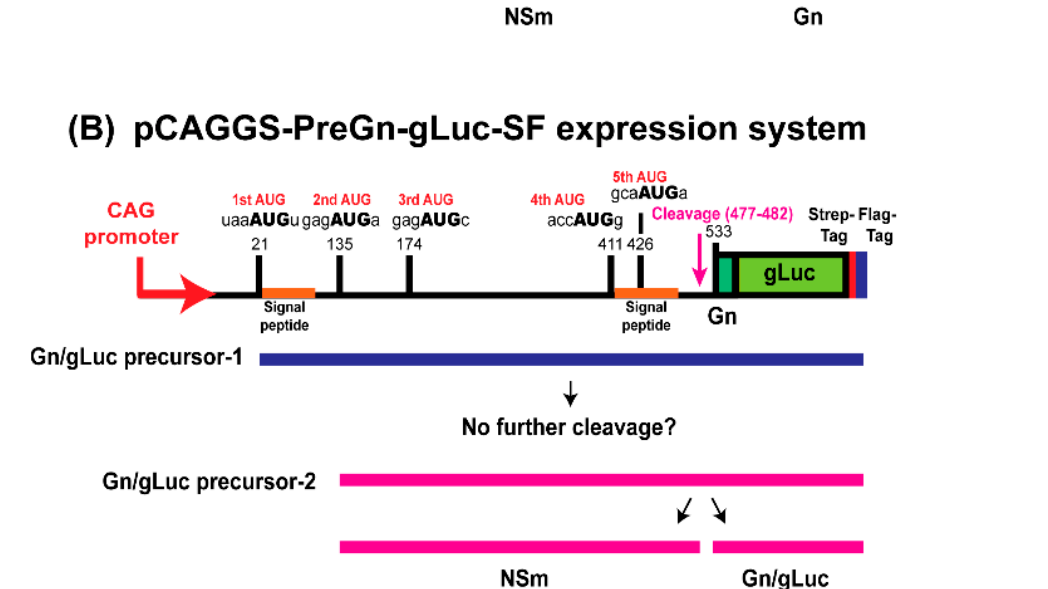
Figure 1. Gene expression of the RVFV M-segment and pCAGGS-PreGn-gLuc-SF. ( A ) The polypeptides synthesized from the 1st AUG (78 kD-Gc) or the 2nd AUG (NSm-Gn-Gc) are cleaved by signal peptidases [14,16,28]. The 78 kD protein and Gc are generated from the 78 kD-Gc precursor, while NSm, Gn, and Gc are made from the NSm-Gn-Gc precursor; ( B ) the pre-Gn region was fused to the gLuc ORF lacking the intrinsic signal peptide, which allows for secretion from the cell via Gn signal peptide. The Gn/gLuc precursor-1 makes a chimeric protein consisting of the pre-Gn region and gLuc, while the Gn/gLuc precursor-2 generates NSm and the Gn/gLuc fusion protein.